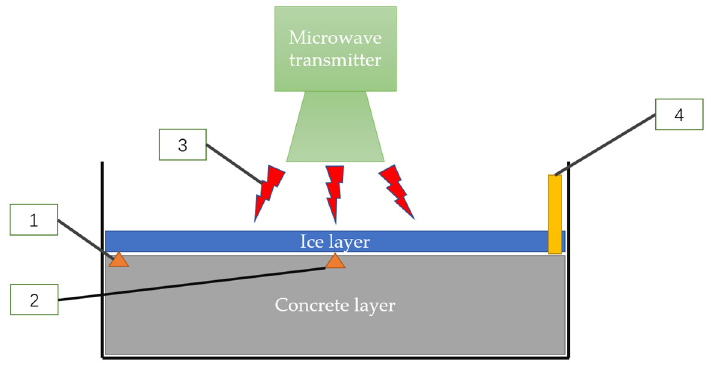
Figure 4. Schematic diagram of the basic test device.